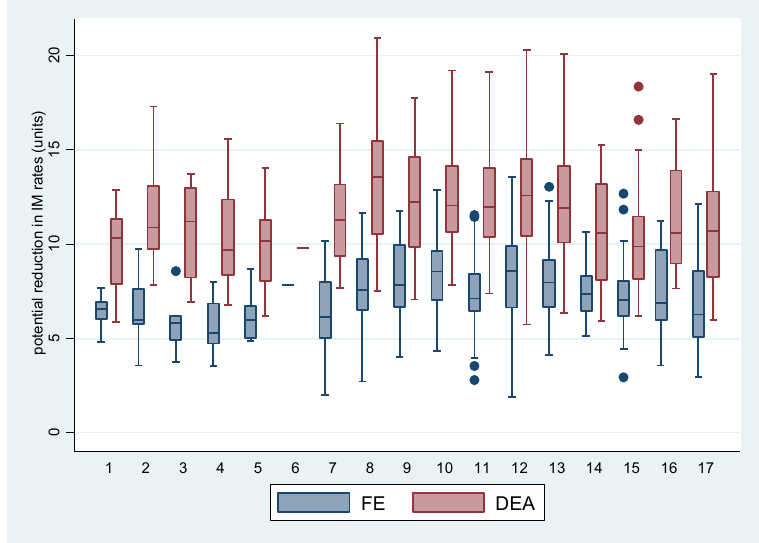
Figure 2. Distribution of potential reduction in the Infant Mortality rates: comparison between meth- ods (FE and DEA), according to Regionalized Healthcare Networks (RRAS). Note: Additional mu- nicipalities with greater potential to reduce their IM levels were found in RRAS 8 (Barra do Chapéu), RRAS 9 (Uru and Coronel Macedo), RRAS 17 (Canas) RRAS 10 (Timburi), RRAS 12 (Mira Estrela and Gabriel Monteiro) and RRAS 13 (Altair and Trabiju). Jambeiro and Eldorado, in the opposite direction, remained as reference municipalities, in addition to Novais and Cedral (RRAS 12), Mirante do Paranapanema (RRAS 11), Águas de São Pedro (RRAS 14), Cosmópolis (RRAS 15) and Ilhabela (RRAS 17). RRAS: Greater SP (1. ABC, 2. Alto Tietê,3. Franco da Rocha, 4. Mananciais, 5. Rota dos Bandeirantes and 6. Capital); 7. Registro and Santos; 8. Sorocaba; 9. Bauru; 10. Marília; 11. Presidente Prudente; 12. Araçatuba and São José do Rio Preto; 13. Ribeirão Preto and surroundings;